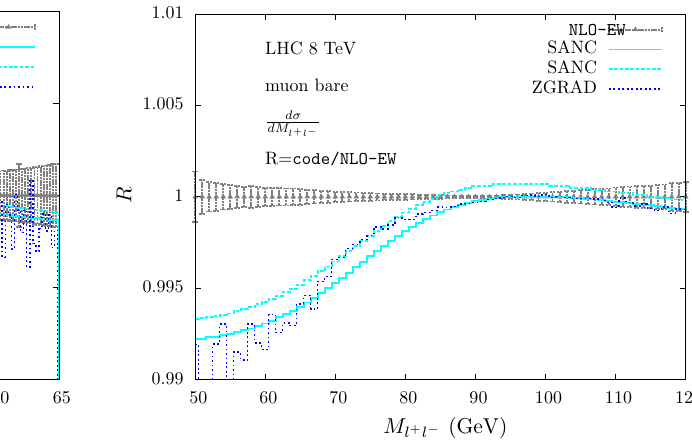
( right ) distributions, obtained for the 8 TeV LHC with ATLAS/CMS cuts.In blue the WZGRAD results;in lightblue the SANC resultsobtained in a linear ( solid ) [first term of Eq. (11)] and quadratic ( dashed ) [both terms of Eq. (11)]